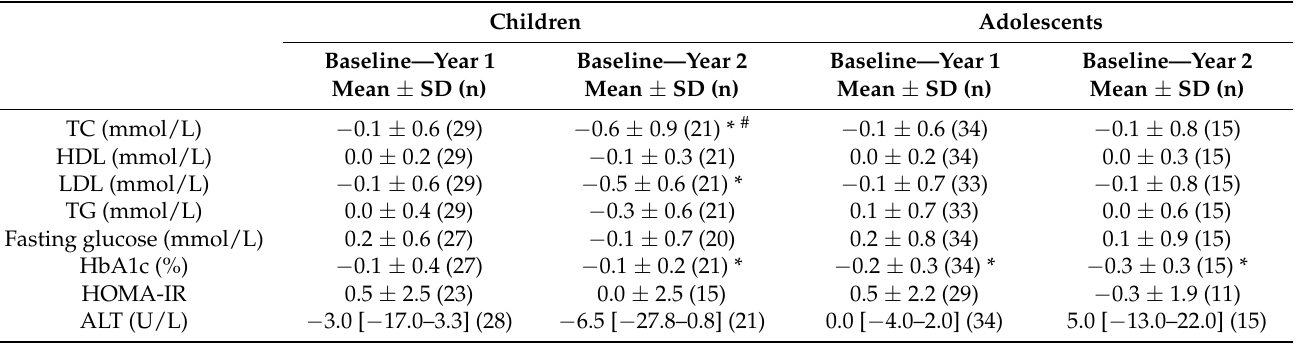
Table 2. Change in cardio metabolic health parameters after one and two years of intervention in and between children and